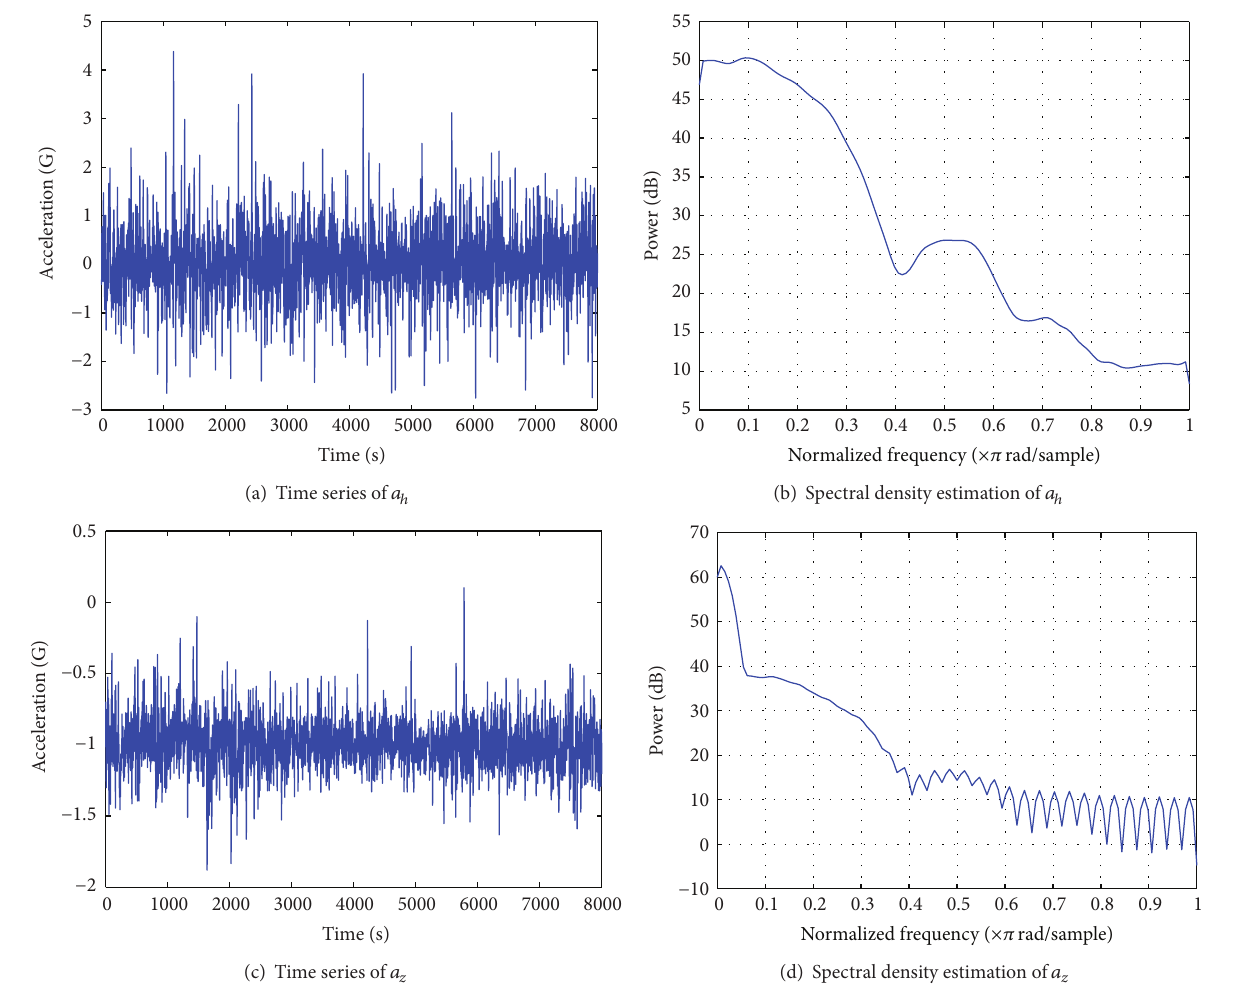
Figure 2: Time series and spectral density estimation (the top plane is produced from the signal of lateral vibration and the bottom plane is produced from the signal of longitudinal